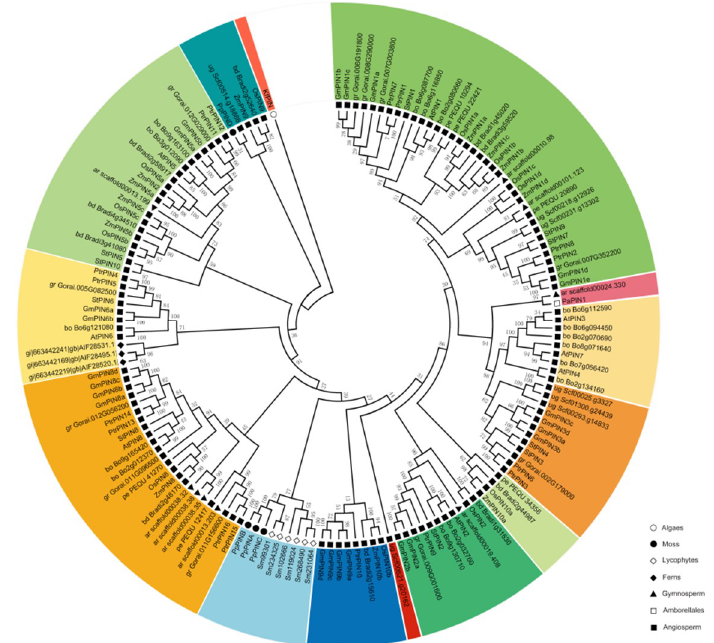
Figure 1. Phylogenetic analysis of PIN auxin transporter of 19 plant species. The putative full-length amino acid sequences of PIN genes were aligned by ClustaXI (2.1) with a partial EST-based PIN sequence of Klebsormidiophyceae (Streptophyte algae). Neighbor-joining tree was constructed by Mega7 with the statistical parameters using poisson model, and pairwise deletions. Accession numbers of the PIN proteins were listed in Additional file: Table S1. The 155 PIN proteins from 19 plant species can be classified into 14 distinct clades and differentiated in color. Different lineages were distinguished by several geometric shapes with hollow or solid. The bootstrap values with 1000 replicates were placed on the nodes.